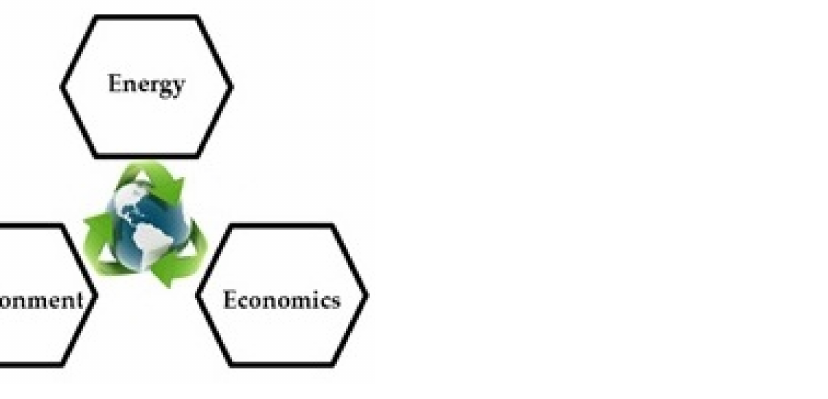
Figure 1. Challenge for technology innovation, integration, and efficiency of usage through the balance estimation among energy, the environment, and the